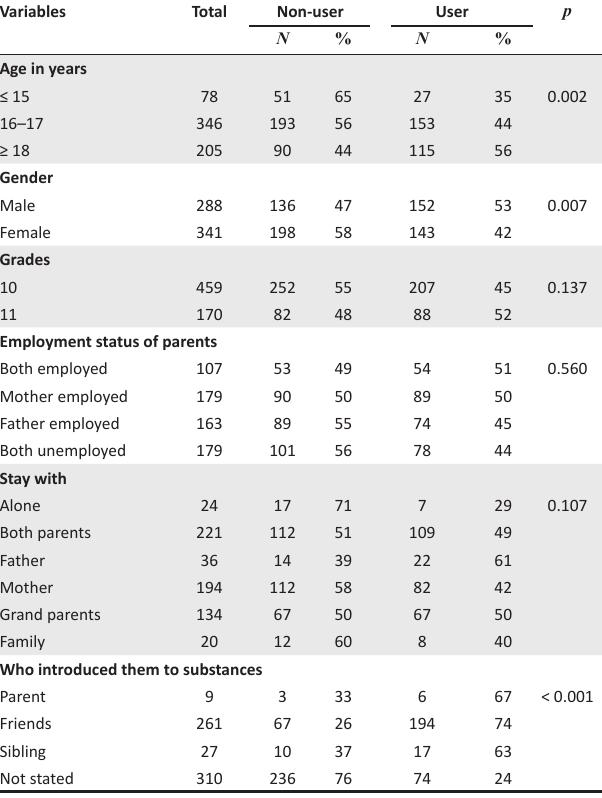
TABLE 2: Association between demographics and substance use. TABLE 1: Prevalence and types of substance use among learners ( n = 295).